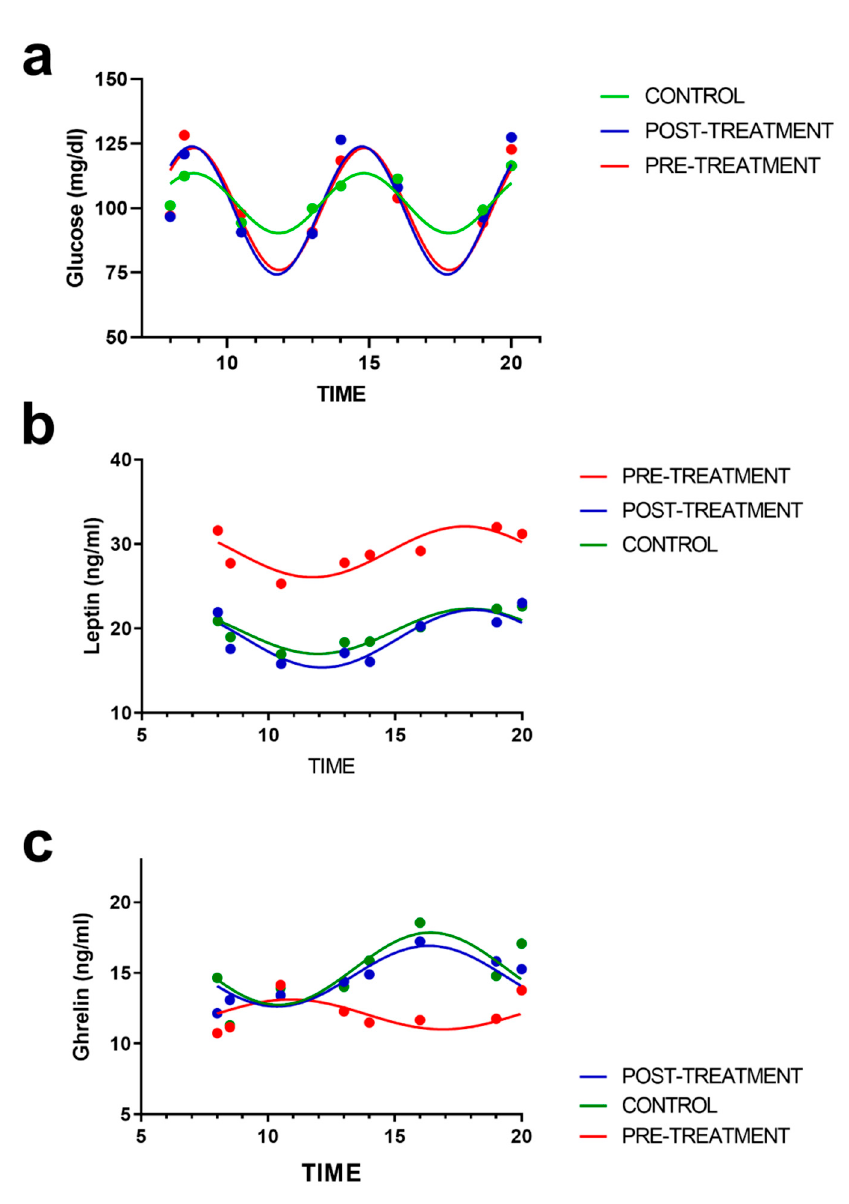
Figure 4. Circadian variation in the daily synthesis levels over time for ( a ) glucose, ( b ) leptin, and ( c ) ghrelin in the control ( n = 13) and obese subjects at baseline ( n = 18) and after 12 weeks of treatment ( n = 15). Dots indicate the mean value. The curve represented for each group corresponds to the best-fitted model obtained by population multiple-component analysis.